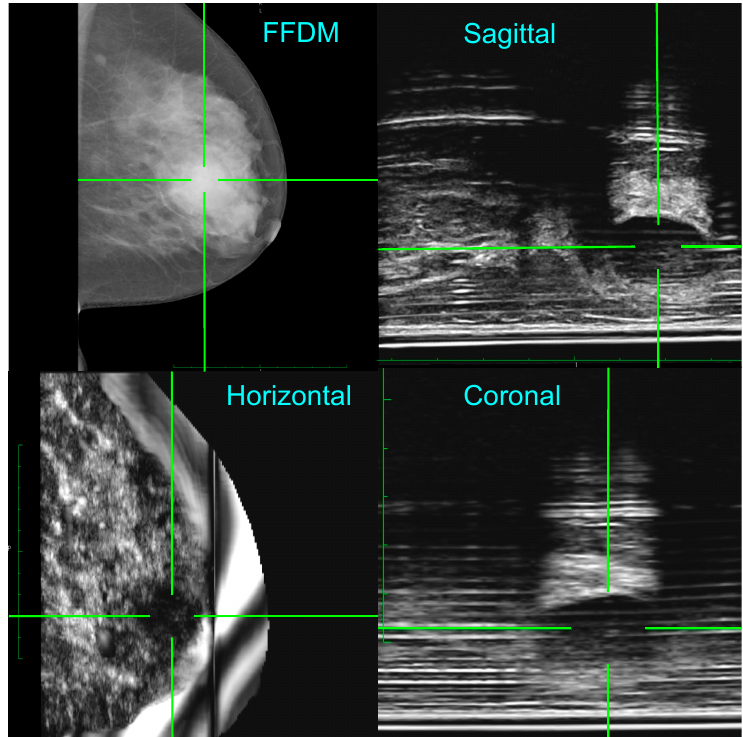
Figure 4. Co-registration of the FFDM in the horizontal plane and the ABUS images in the horizontal, coronal, and sagittal planes for Patient 1. A lesion (benign cyst) has been highlighted by cross hairs in both the FFDM and ABUS views. Note that for the ABUS images, the sagittal plane view is the acquired image, whereas the coronal and horizontal plane views have been reconstructed.